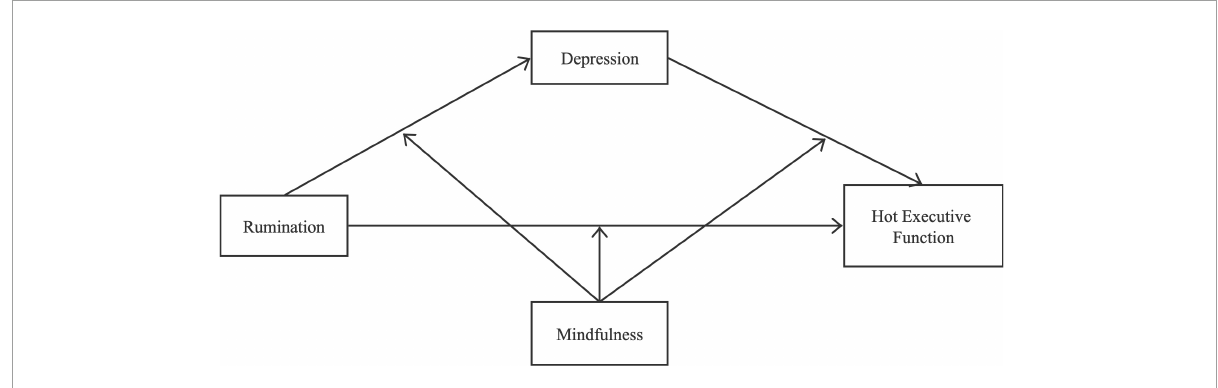
FIGURE1 The proposed theoretical model.